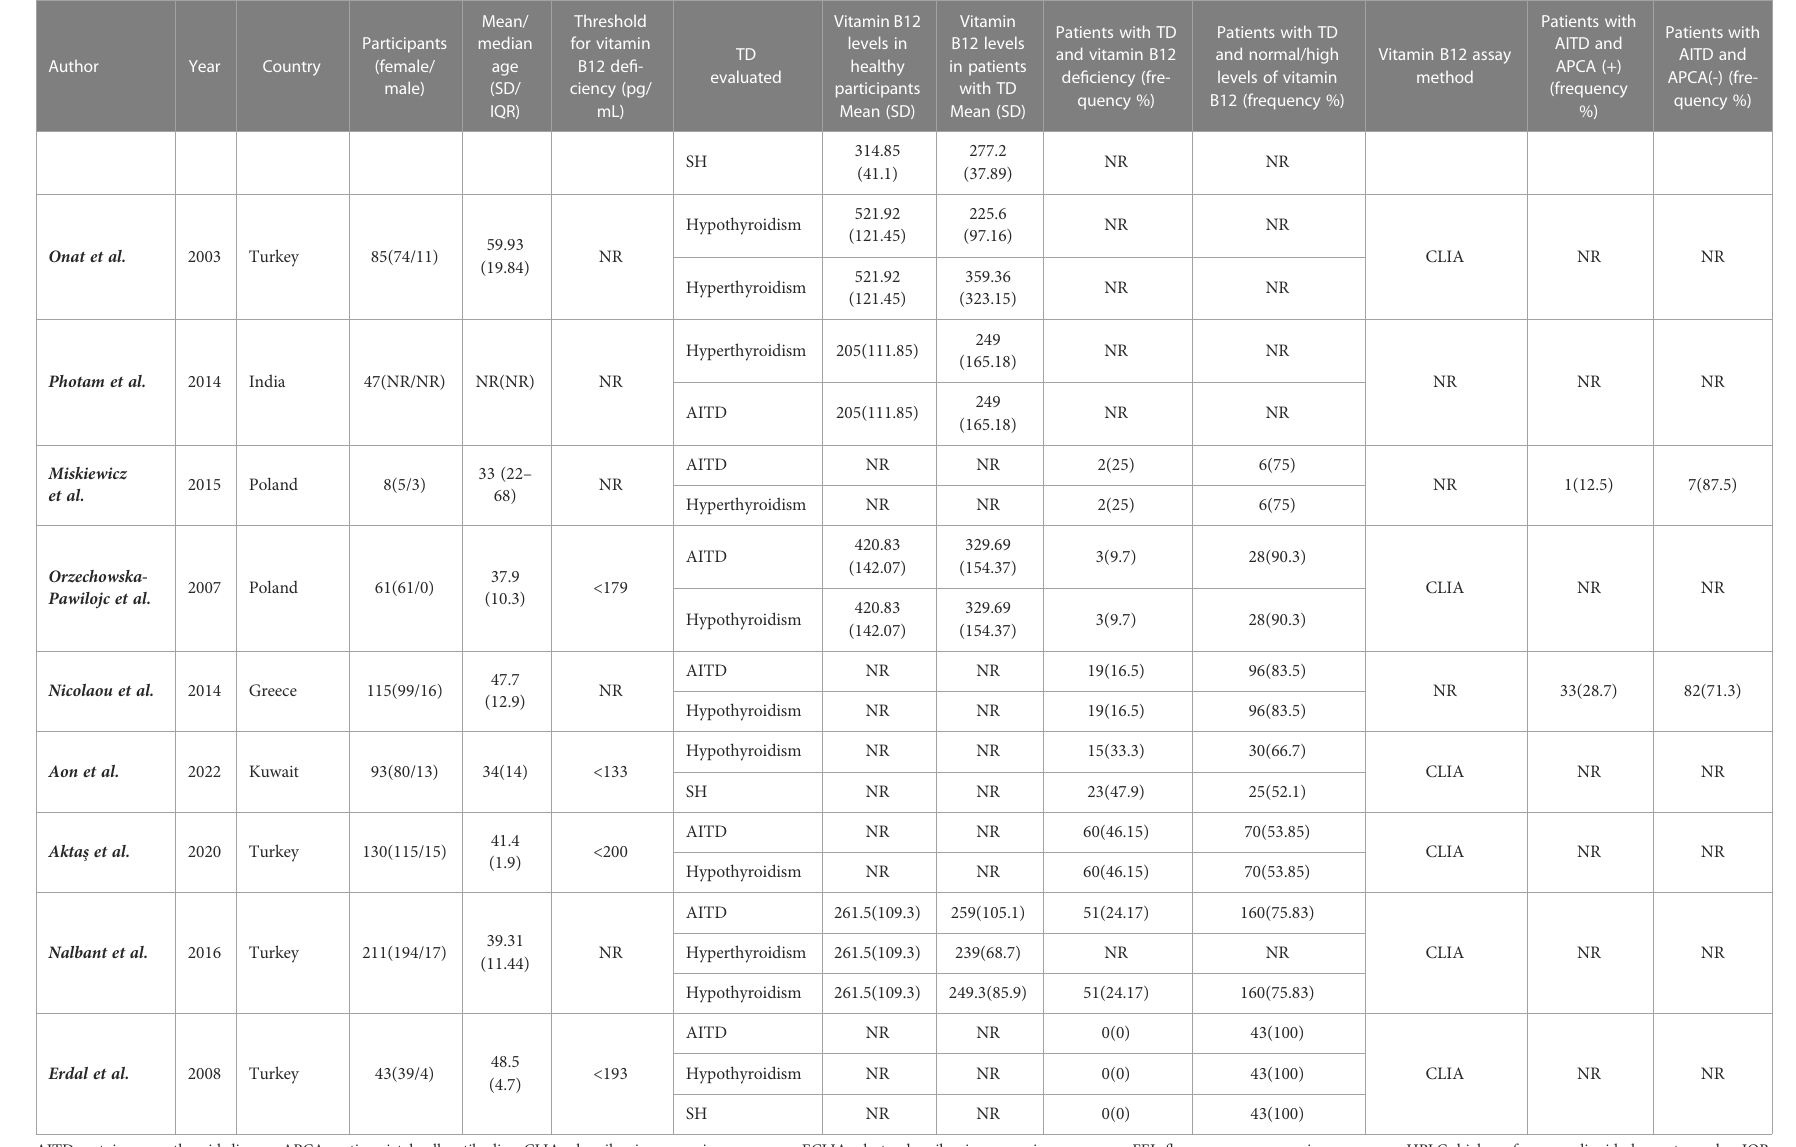
AITD, autoimmune thyroid disease; APCA, anti-parietal cell antibodies; CLIA, chemiluminescence immunoassay; ECLIA, electrochemiluminescence immunoassay; FEI, fl uorescence enzyme immunoassay; HPLC, high-performance liquid chromatography; IQR, interquartile range; NR, not reported; RIA, radio immunoassay; SH, subclinical hypothyroidism; SD, standard deviation; TD, thyroid disorder; 95% CI, 95% con fi dence